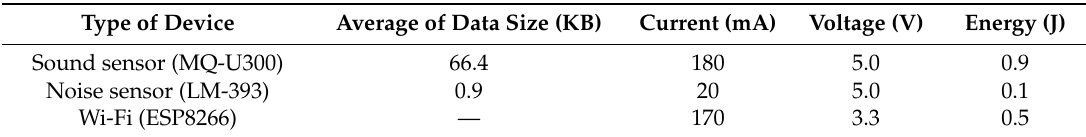
Table 8. Comparison of data size and performance between sound sensor and noise sensor, and Wi-Fi